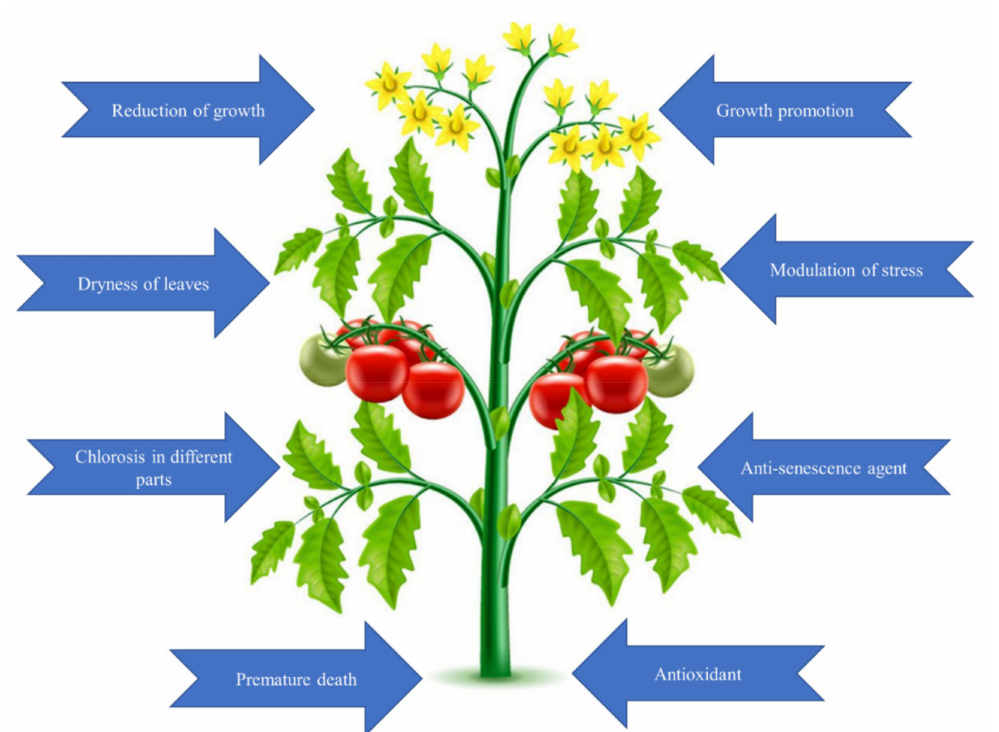
Figure 2. Demonstration of useful and harmful effects of Se on plant